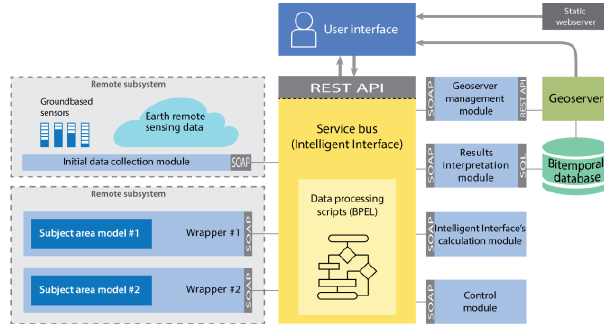
Figure 1. Generalized scheme of the information system for operational flood forecasting